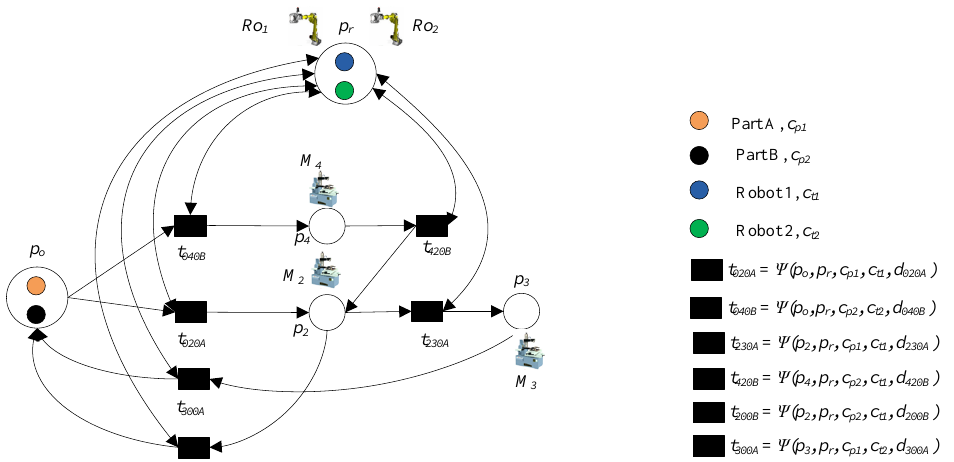
Figure 6. An ICTPN for the reconfigured system by removal of an old